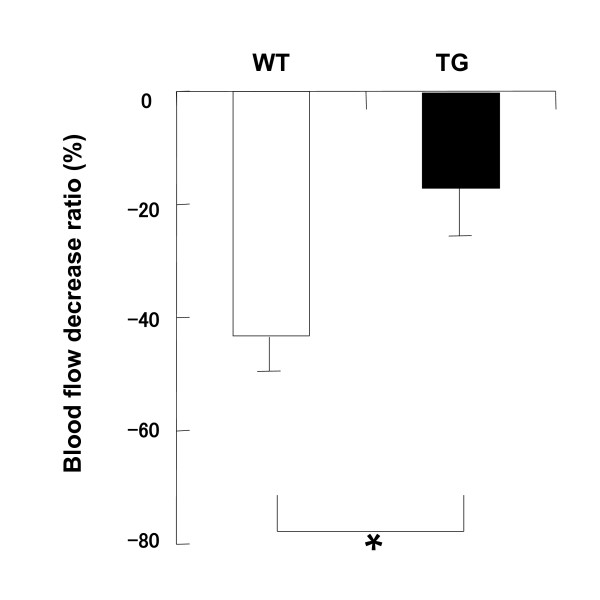
Assessment of gastric mucosal blood flow in the gastric mucosae. Gastric mucosal blood flow was assessed by comparing the blood flow ratio before and after the ethanol treatment. The ratio was obtained as a percent against the blood flow before the treatment, which was much larger in the WT mucosa than in the TG mucosa. *p < 0.03.